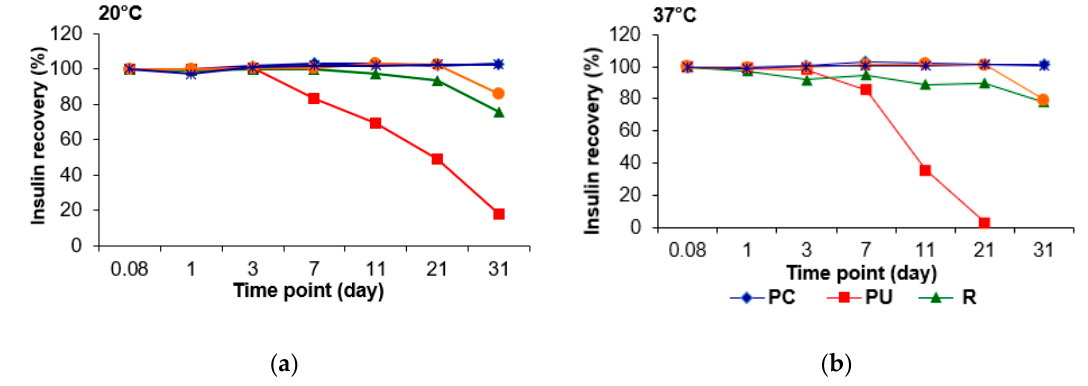
Figure 3. ( a ) Hum R insulin recovery over time for each test material at 20 °C and ( b ) 37 °C for method B.